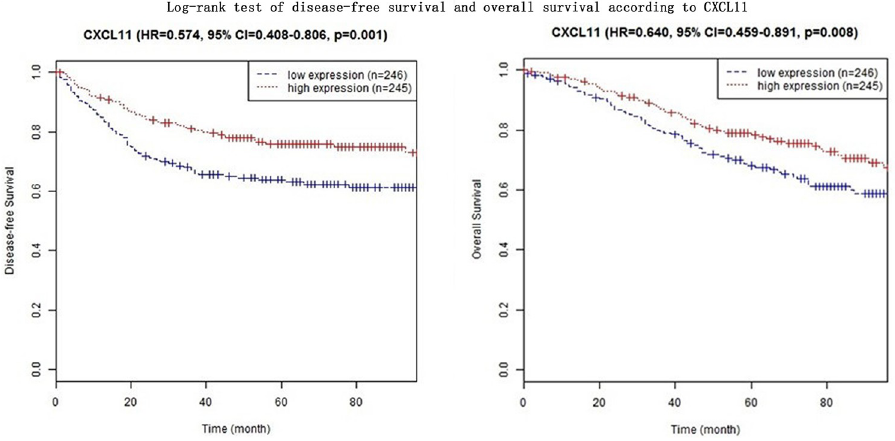
Fig 3. Log-rank test of disease-free survival and overall survival according to